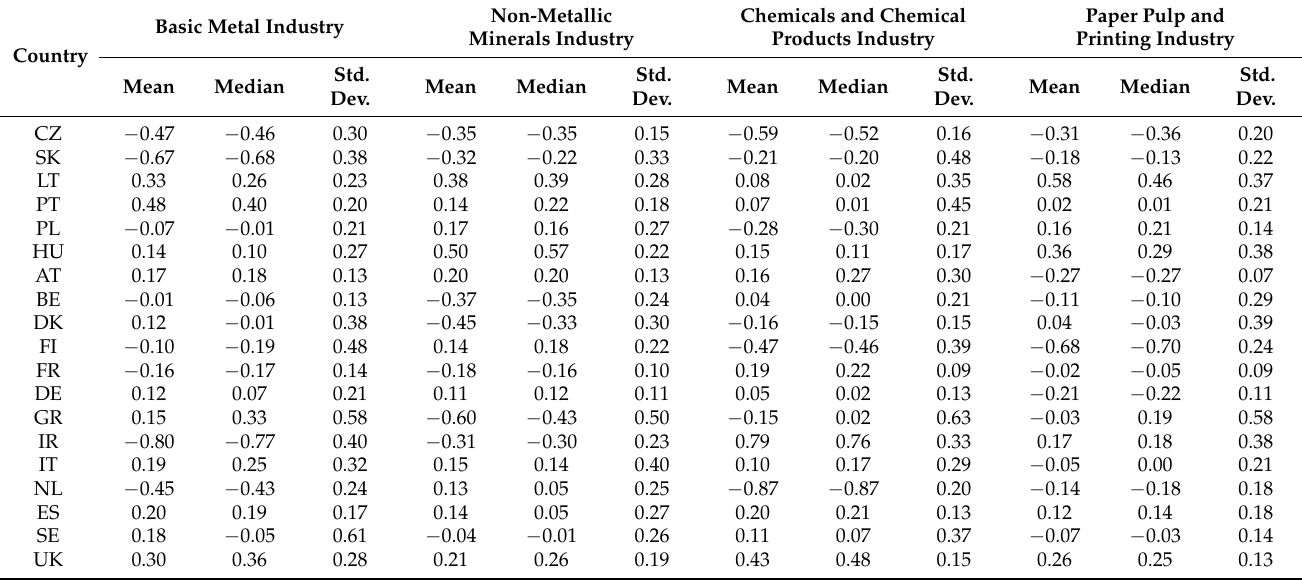
Table 1. Average, median, and standard deviation index values in 2009–2018. Source: own processing. Basic Metal Country